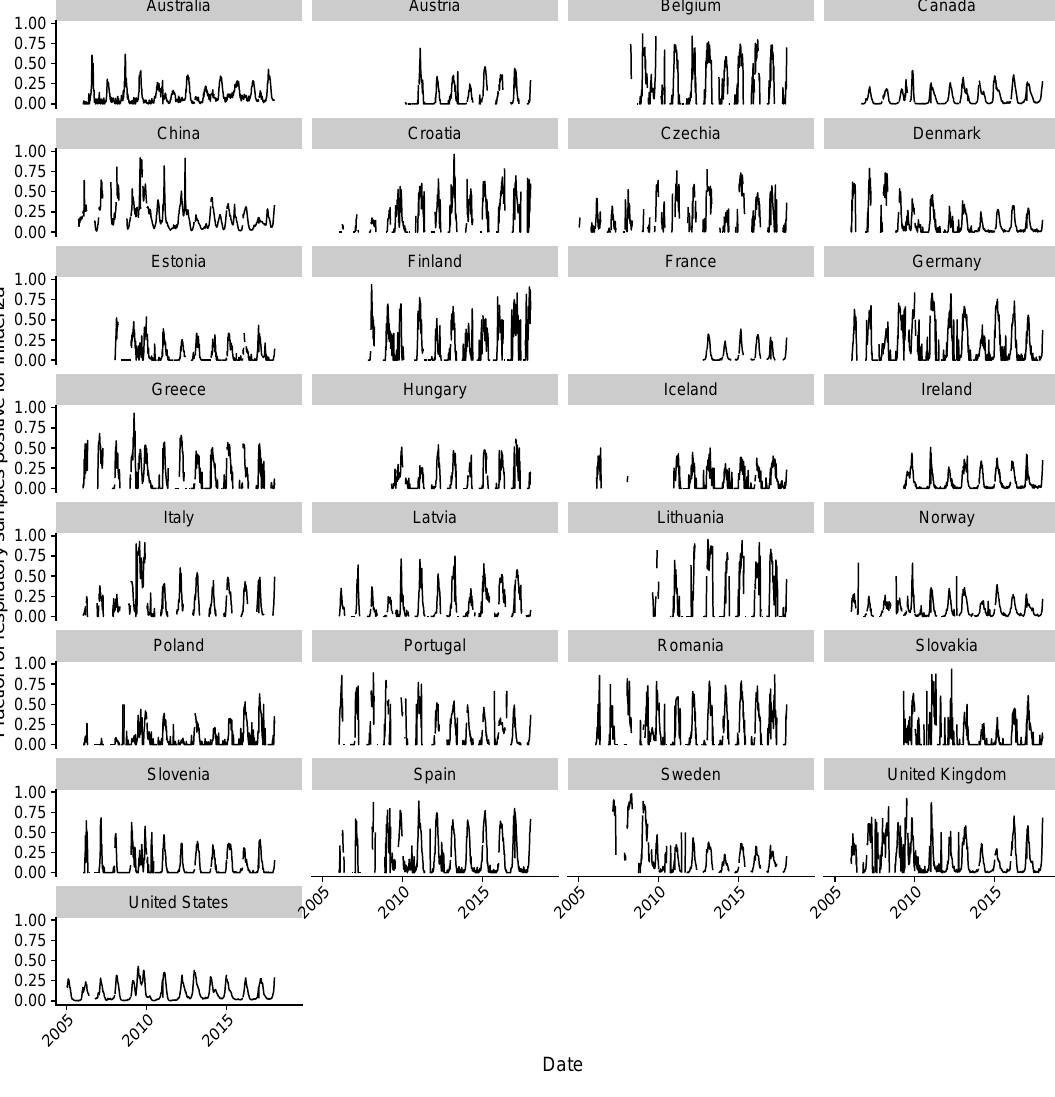
Figure A19. As in Figure A8, but using a fixed y -axis scale for